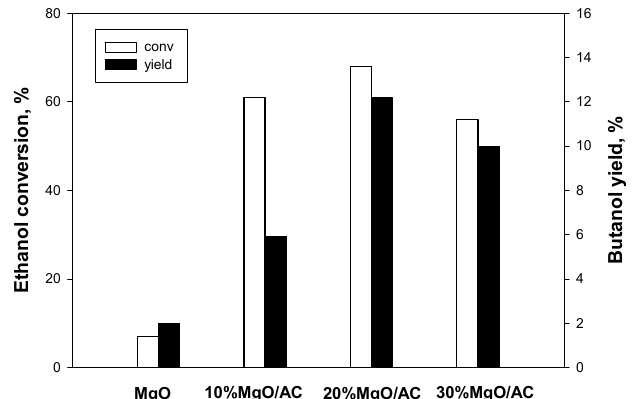
Figure 5. Ethanol conversion and butanol yield obtained in catalytic tests on pure MgO and AC supported MgO catalysts at T = 400 °C and GHSV = 330 h − 1 .